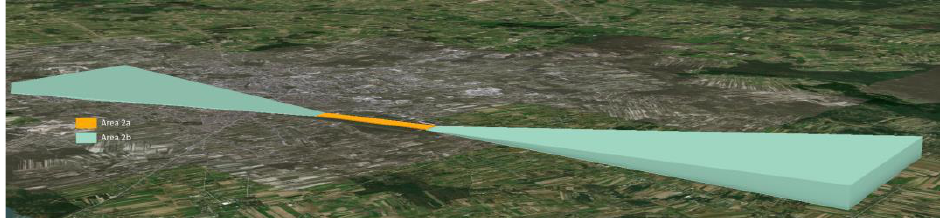
Figure 8. Obstacle data collection surfaces — Area 2a and area 2b (side profile view).